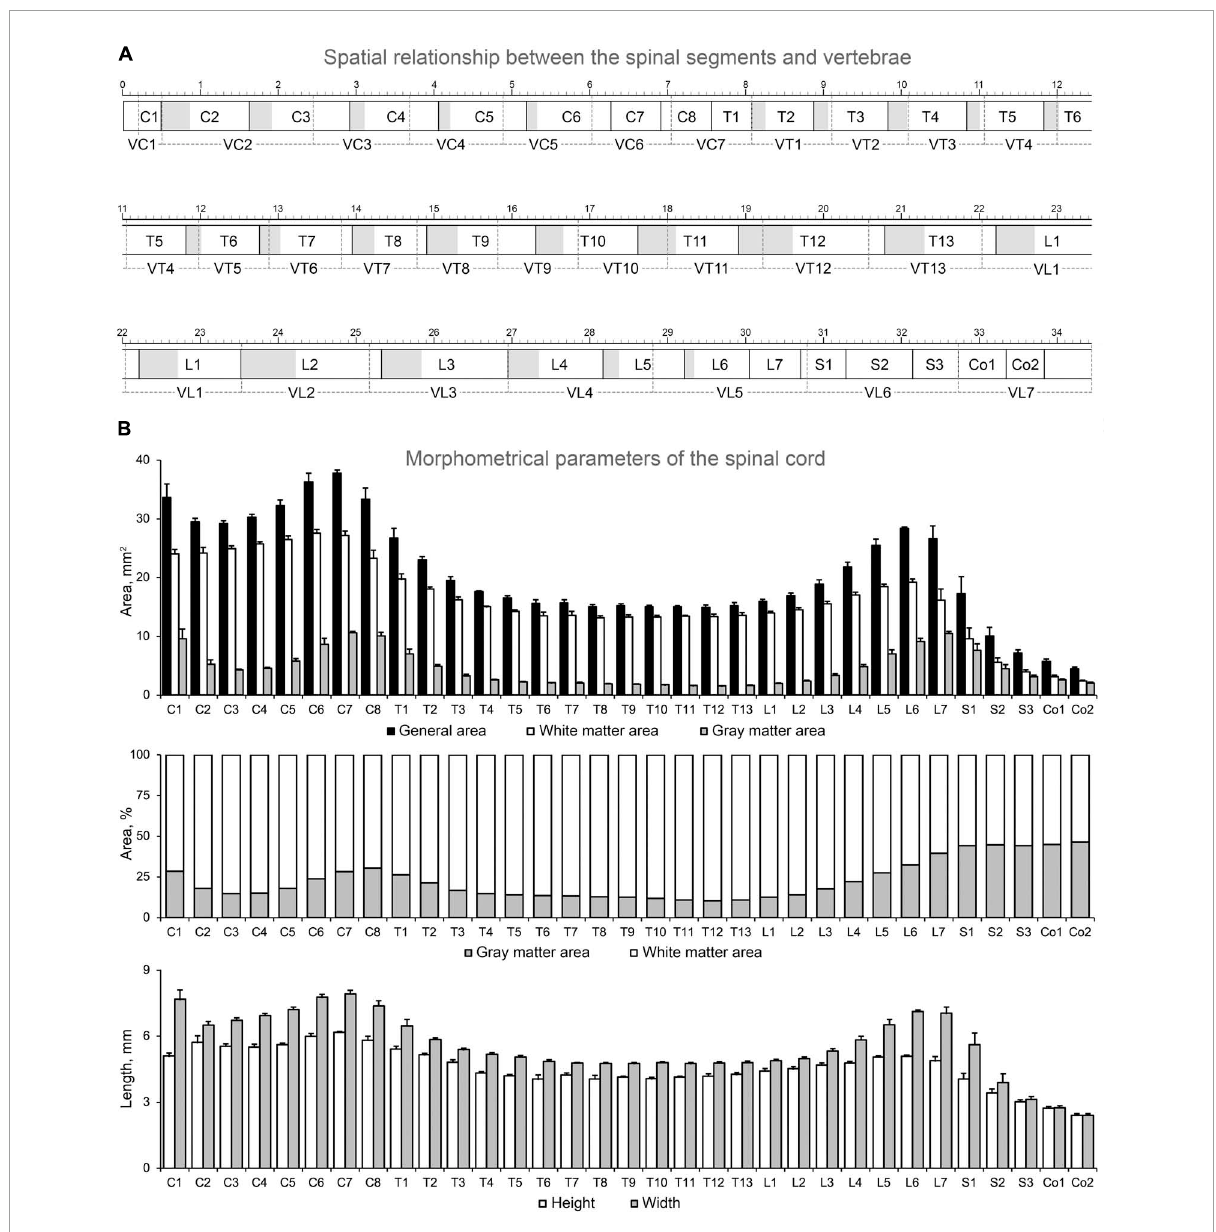
FIGURE2 Spatial relationship between the spinal segments and vertebrae (A) and morphometric data about the spinal cord of the cat used (B) . Rectangles with black solid borders, segments; gray part, interrootlet zone; white part, rootlet zone; rectangles with dashed borders, vertebrae; the large-scale bar is 1